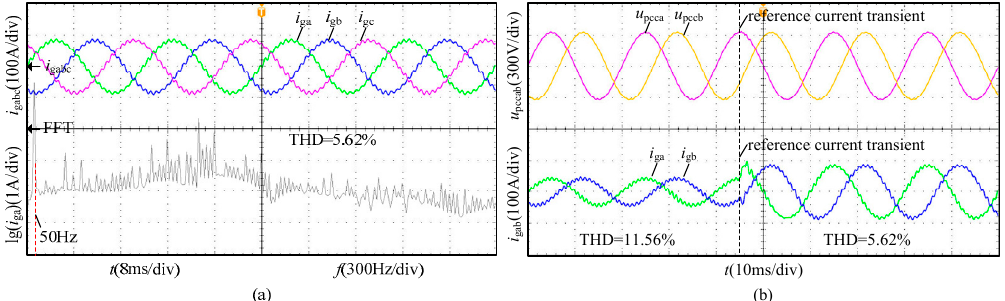
Figure 18. Experimental waveforms of u pcc and i g with proposed admittance reshaping technique 1 without the parameter design range. ( a ) Steady state; ( b ) Transient.